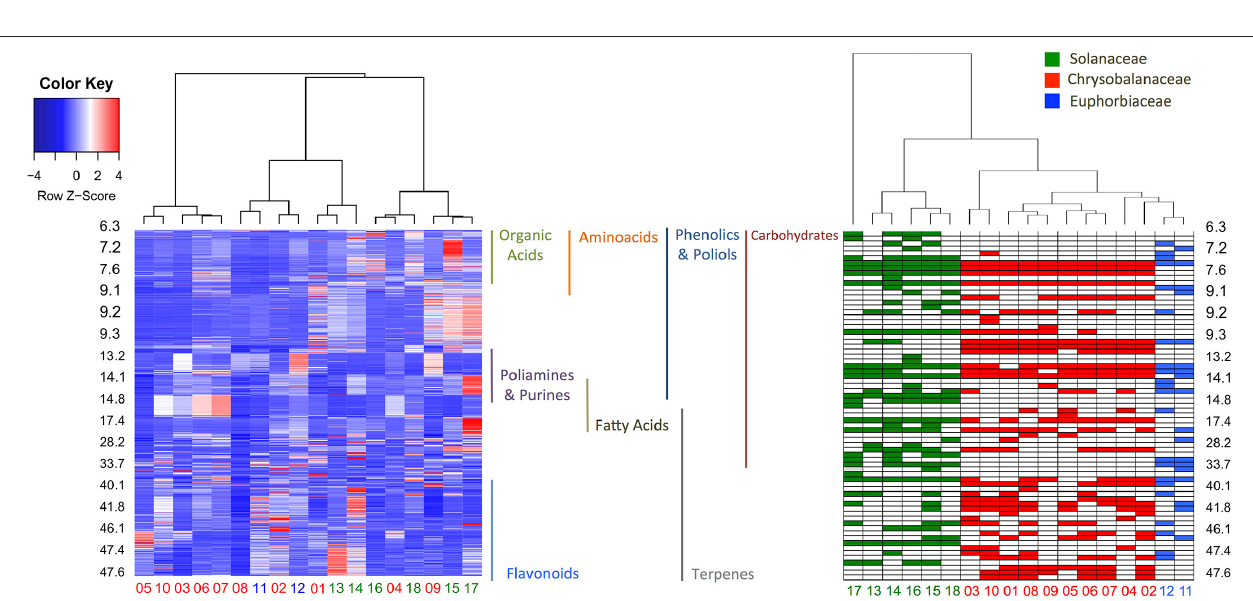
FIGURE 5 | HCA heatmap comparing the GC-MS raw data (left) and AMDIS-RAMSY-based identified metabolites (right). The GC-MS raw data heatmap (color key box—upper left) represents the metabolite concentrations, while the AMDIS-RAMSY color key indicates the presence among taxa families. The identified classes of metabolites are shown according to their retention times between the plots.